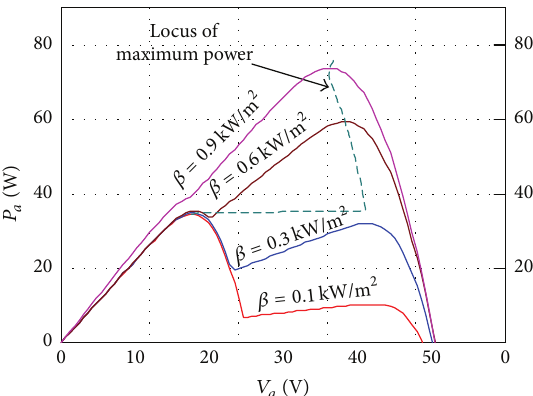
Figure 13: Equivalent circuit of a PV array composed of two series modules, each protected by a bypass diode.